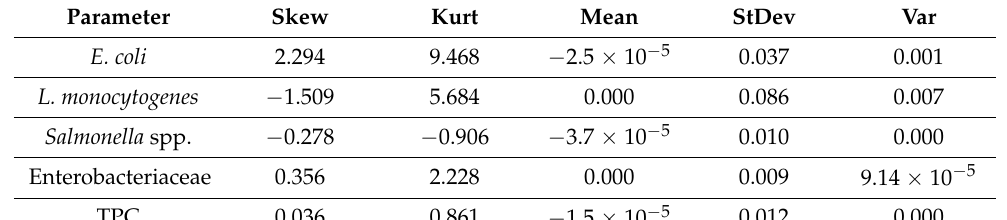
Table 9. The residual analysis for the developed ANN model.